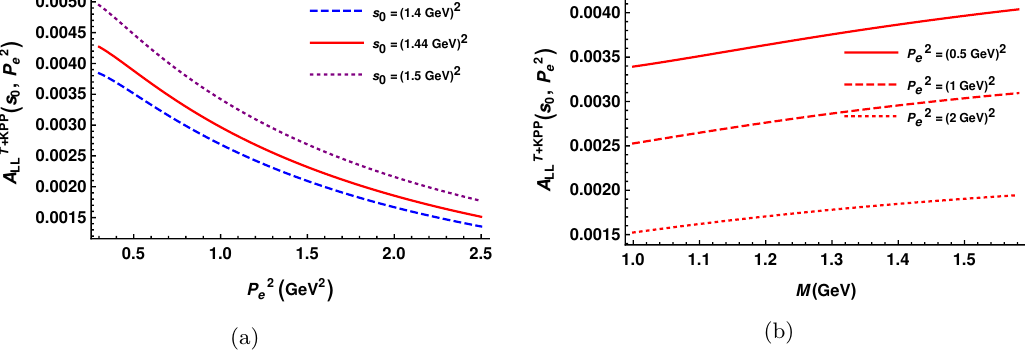
Figure 1 . The physical FF, A LL ( s 0 , P 2 employing photon DAs. Left panel: A TP + KPP (1 . 4 GeV ) 2 (violate dotted), s the Borel Mass, M 2 = 2 GeV 2 . Right Panel: A TP + KPP of P 2 = 0 . 5 GeV 2 (red solid), P 2 e continuum threshold, s